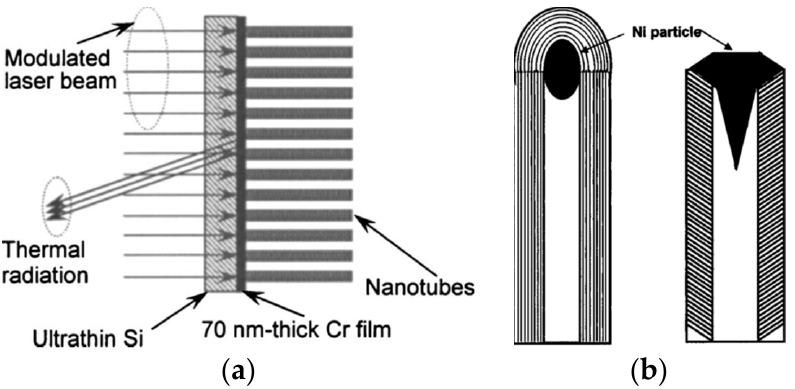
Figure 3. Thermal and structural characterization of CNTs: ( a ) multilayered structure of CNTs; ( b ) schematics of CNTs’ wall growth on a Ni particle with a special structure. Reprinted with permission from Ref. [32], Copyright (2022), AIP Publishing.